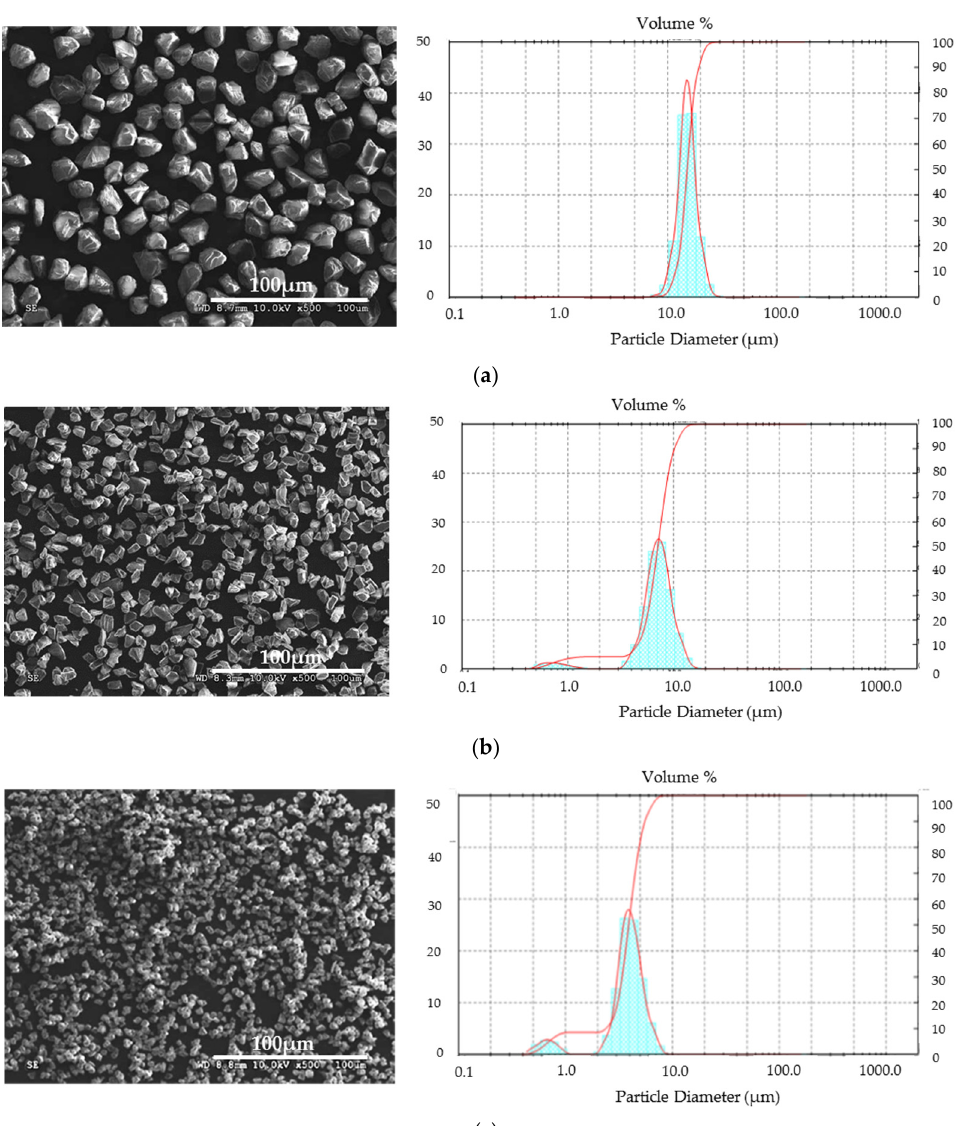
Figure 2. SEM image and particle size distribution of starting diamond powders. ( a ) 16–20 µm ; ( b ) 8–10 µm ; ( c ) 2.5–5 µm.